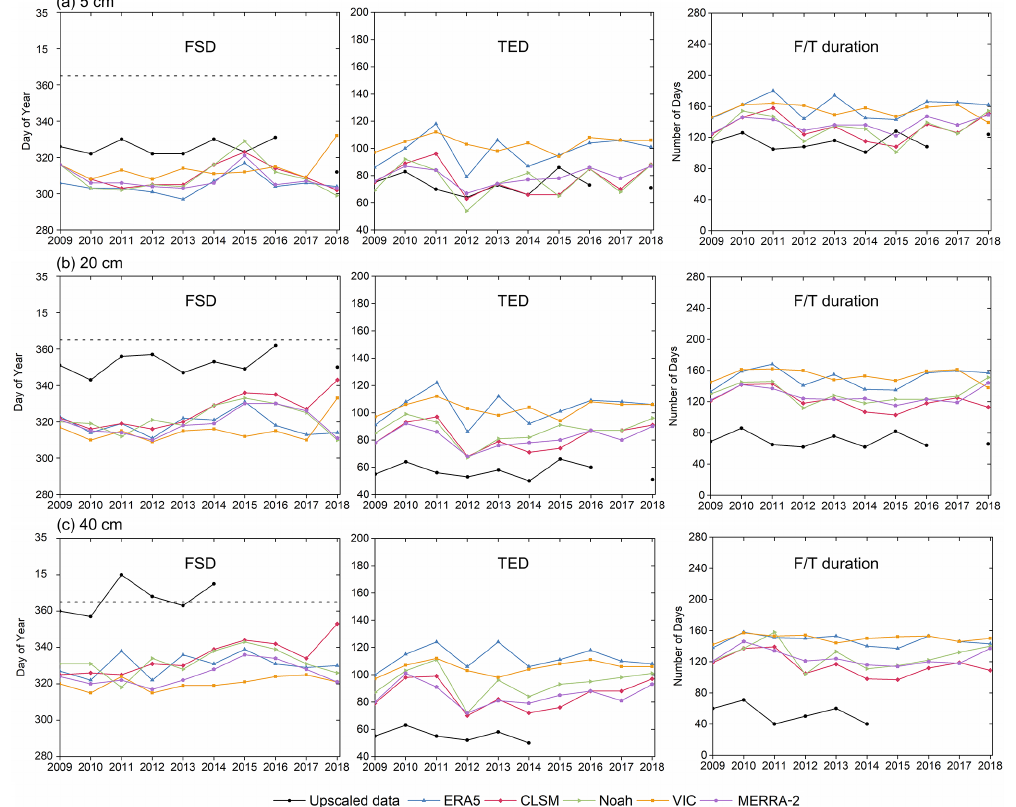
Figure 12. The annual variations in the FSD, TED, and F/T duration at the depths of (a) 5, (b) 20, and (c) 40cm obtained from the upscaled dataset and five model-based products for the Maqu